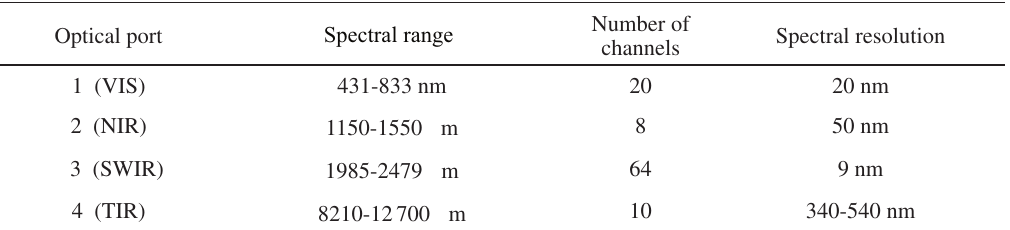
Table II. MIVIS spectral bands characteristics (Bianchi et al ., 1994). Optical port Spectral